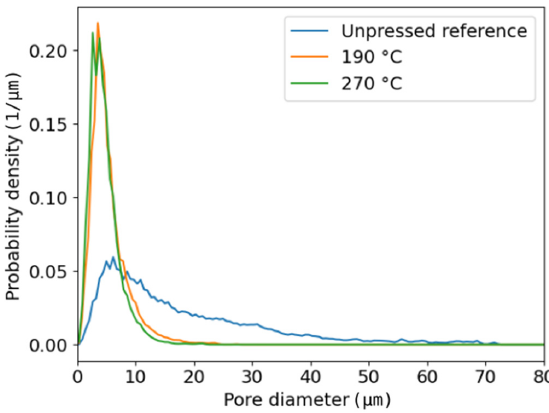
Figure 3. Pore-size distributions for the unpressed reference sheet and hot-pressed sheets with temperature of 190 °C (cylinder press) and 270 °C (steel belt press).